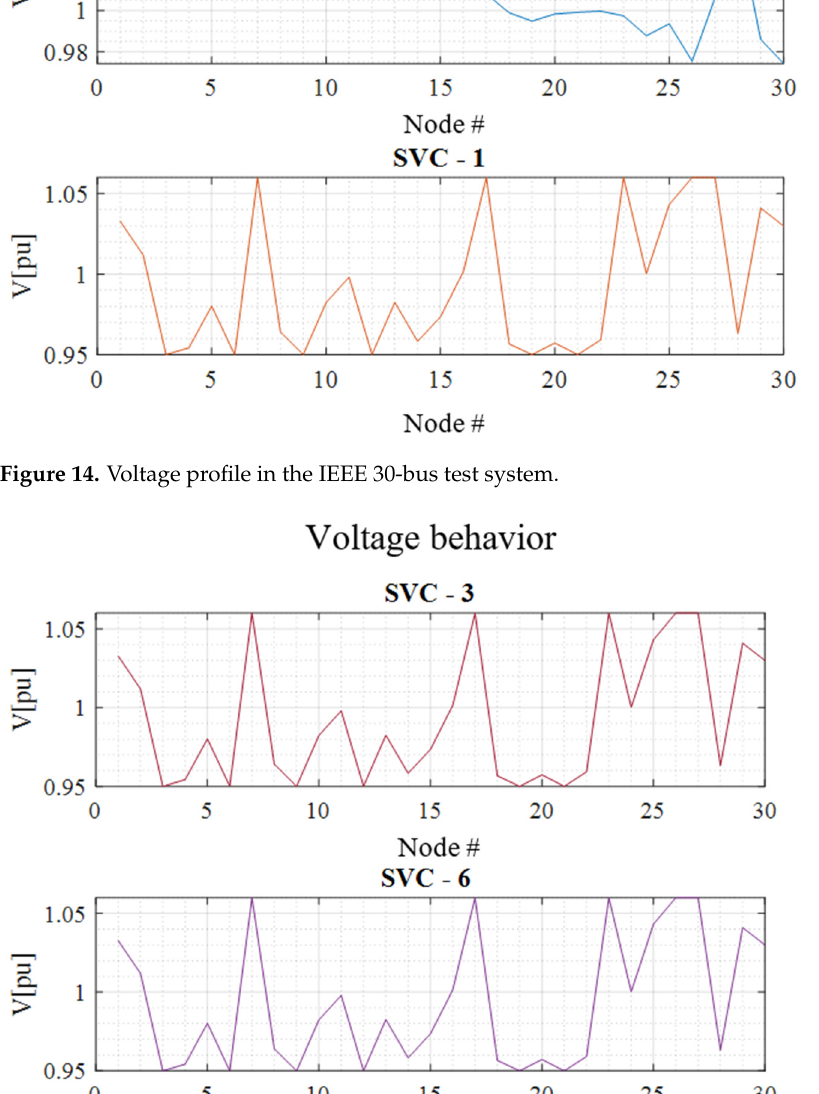
Figure 16. Angle profile in the IEEE 30-bus test system.